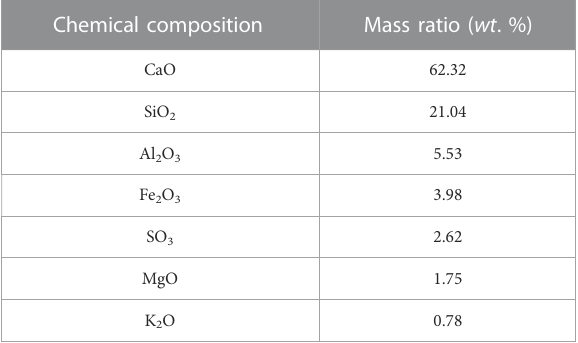
TABLE 1 Physical properties of the soil. Soil property